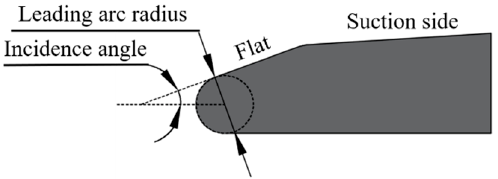
Figure 24 . The circular leading edge with a flat [44] .